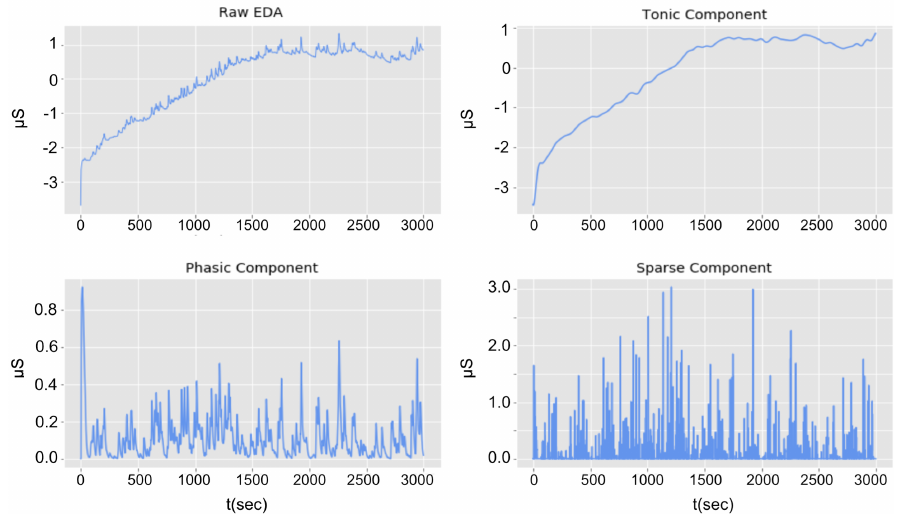
Figure A1. Example of Convex Optimization Approach for EDA Decomposition. ( Top left ): EDA signal (z-score). ( Top right ): Tonic component. ( Bottom left ): Phasic component. ( Bottom right ): Sparse component (phasic